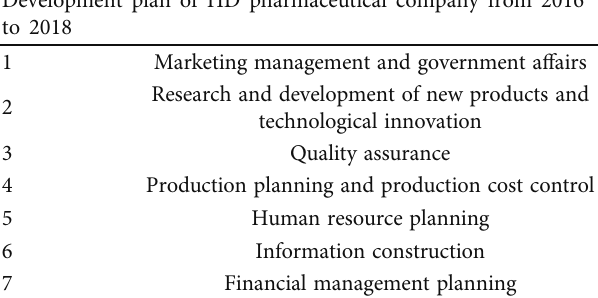
Table 5: Development plan from 2016 to 2018.